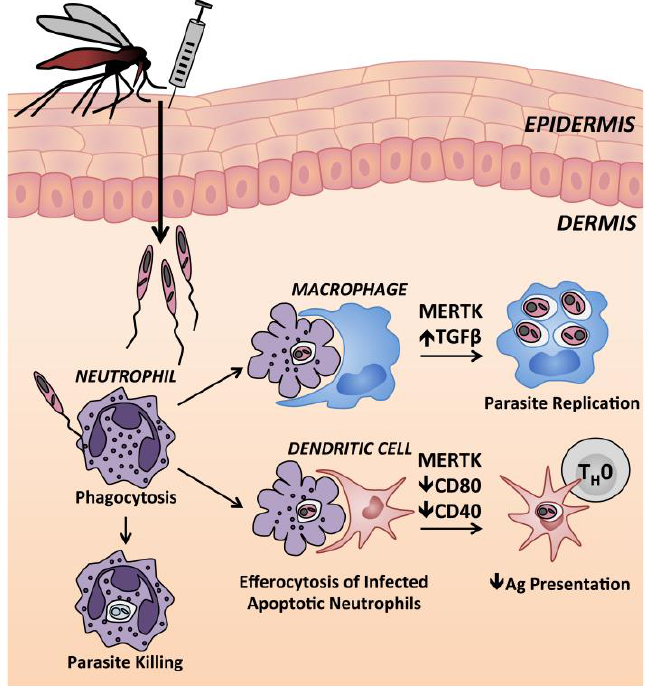
Figure 3. Neutrophils at the cutaneous site of Leishmania spp. inoculation in mice. Neutrophils are rapidly recruited to the site of Leishmania infection, initiated by either sand fly or needle inoculation, where they phagocytose parasites. Although some Leishmania are killed by neutrophils, some survive within neutrophils until they undergo apoptosis. Uptake of apoptotic infected neutrophils by macrophages leads to MERTK signaling and increased TGF β release, promoting an anti-inflammatory macrophage state and intracellular parasite replication. DCs that take up apoptotic infected neutrophils show a decreased capacity to present antigen to naïve CD4 + T cells. MERTK: Mer tyrosine kinase; TGF β : Transforming growth factor β , T H 0: naïve CD4 + T cell.